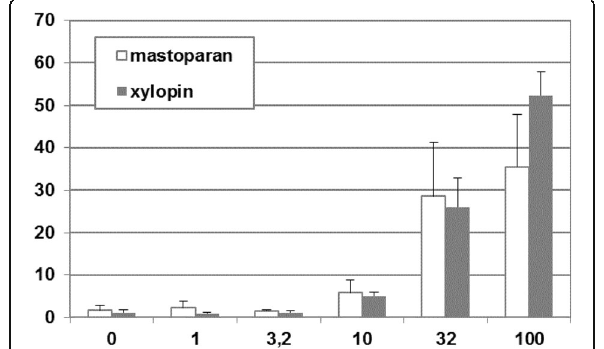
Fig. 4 The degranulation in RBL-2H3 cells (a mucosal-type mast cell model) measured by the β -hexosaminidase release, basal and after treatment with xylopin, the novel venom peptide from the solitary bee Xylocopa appendiculata circumvolans . Concentrations are in μ M and data represent the mean from two to four independent experiments